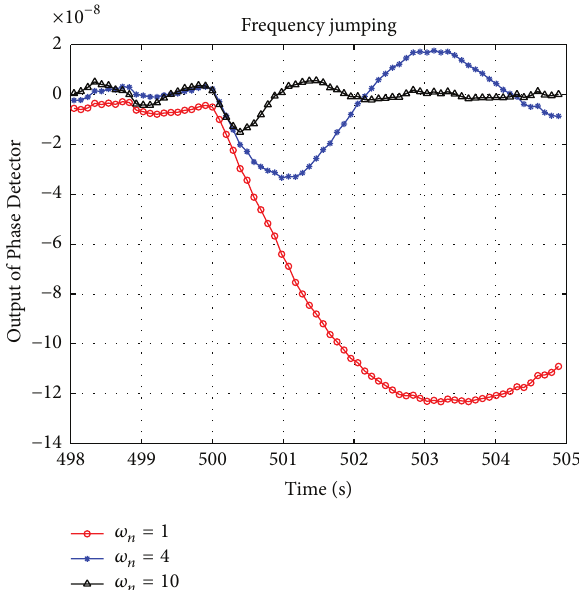
Figure 4: Response of Phase Detector to frequency jumping during simulation.